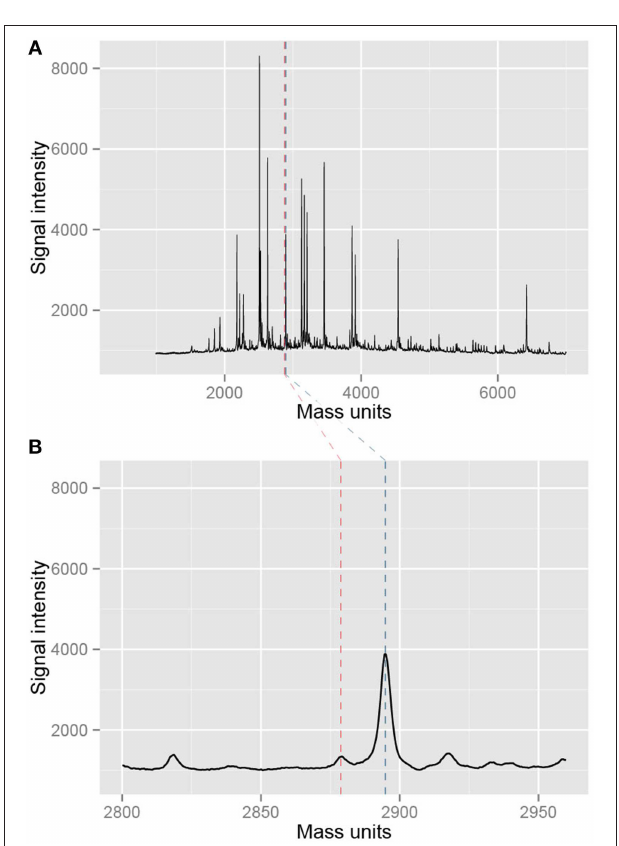
FIGURE 5 | Example of mass spectra resulting from the measurement with EpiTYPER. (A) Shows an entire mass spectrum of a single measurement of a sample. Black peaks are measured fragments while the blue and red dotted lines denote a selected CpG fragment in the EpiTYPER software. This particular part of the mass spectrum is shown in (B) . The spectrum is nice and smooth, indicating a good quality of the measurement.